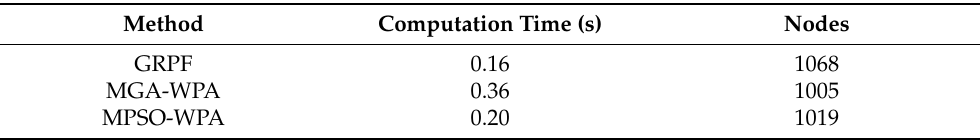
Table 6. Convergence times and final numbers of nodes for the GRPF, MGA-WPA, and MPSO-WPA methods for the stability test of a fractional-order